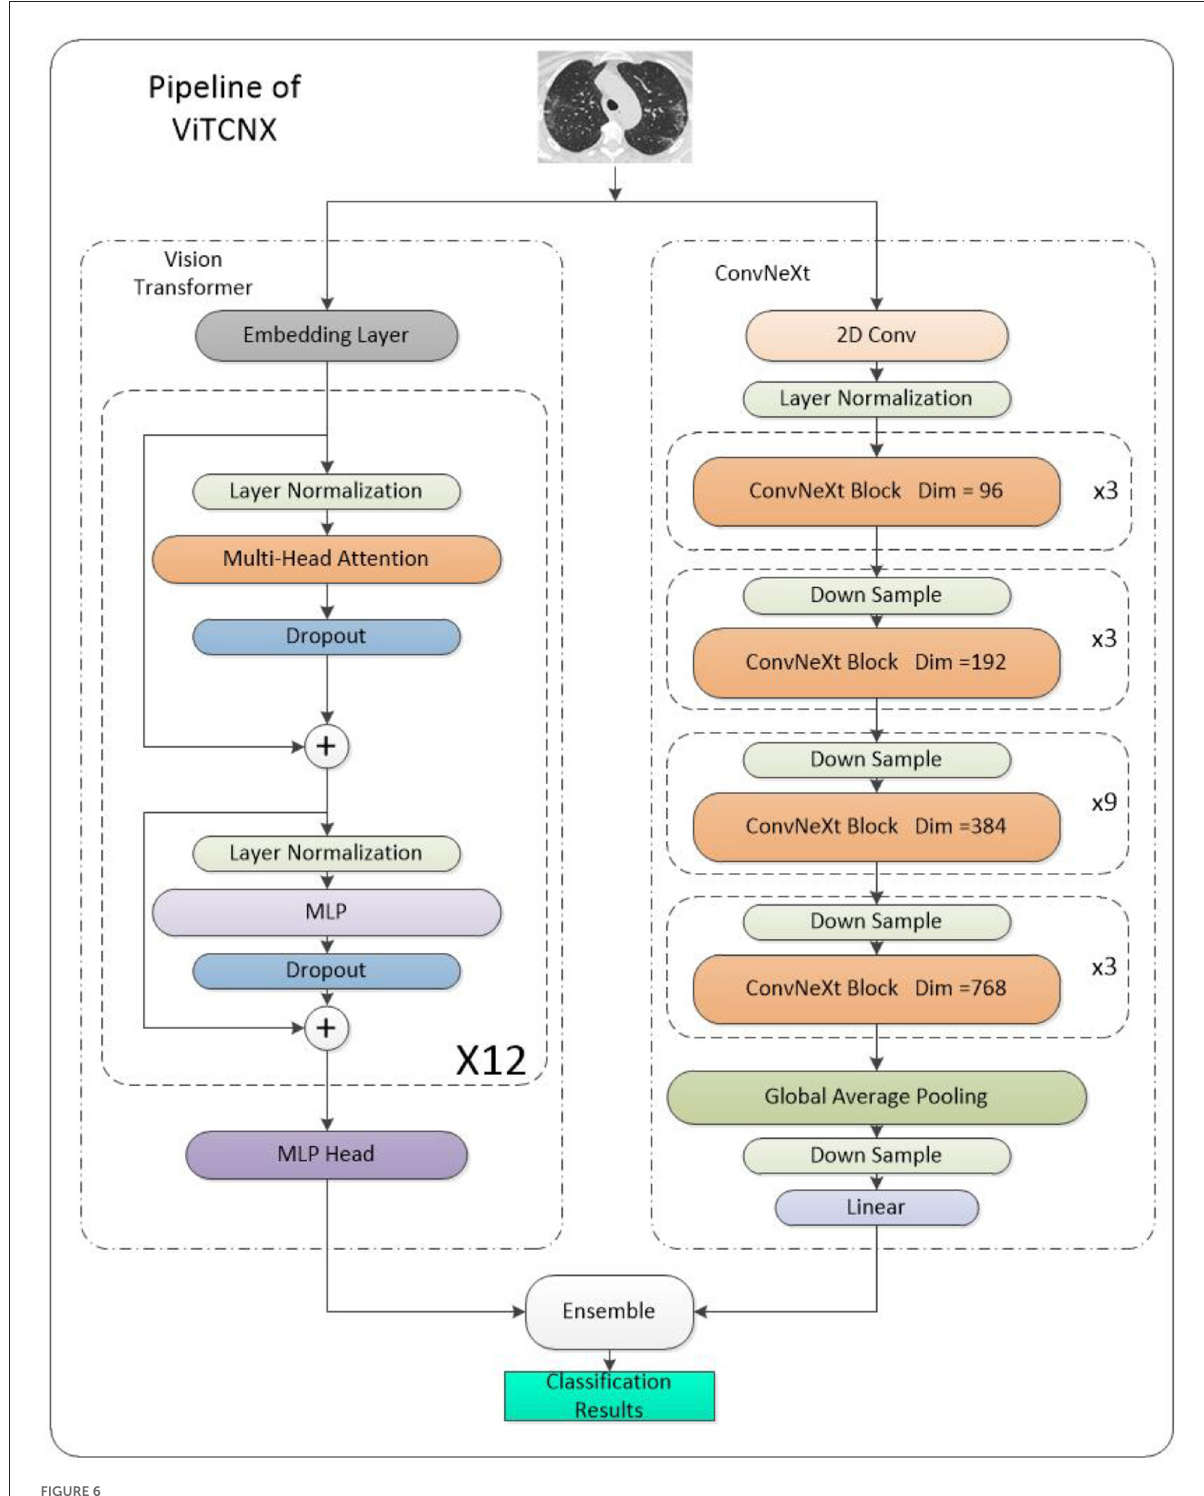
FIGURE6 Pipeline of